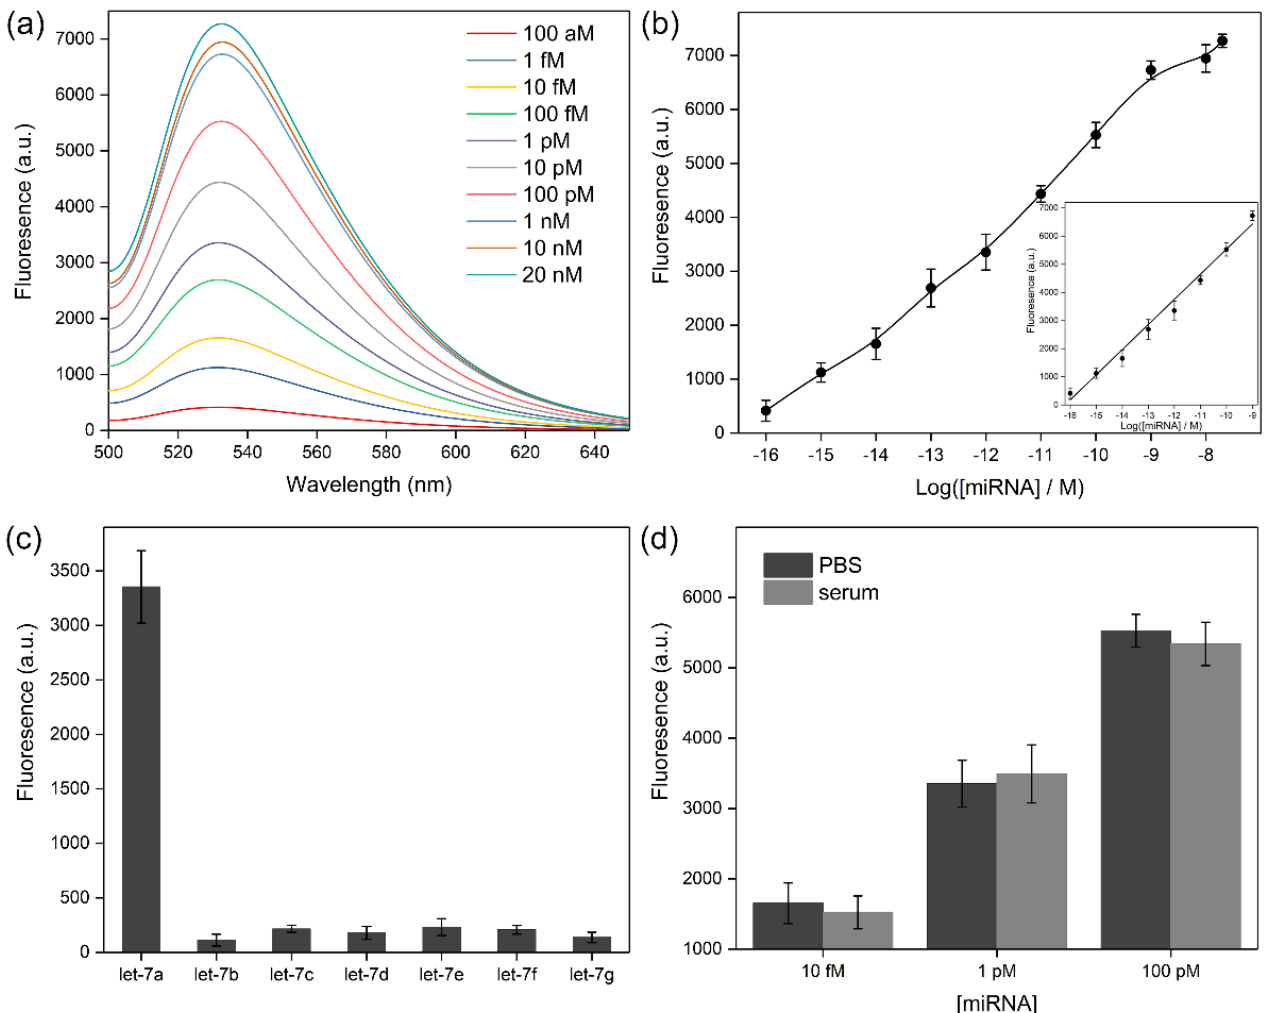
Figure 5. ( a ) Fluorescence emission spectra for the detection of miRNA with different concentrations. ( b ) Calibration curve representing the relationship between peak intensity and miRNA concentration. Inset is the linear range. Error bars represent standard deviations of three independent measurements. ( c ) Selectivity investigation of target and homology miRNAs. ( d ) Fluorescence performances of the sensor in PBS buffer and serum samples spiked with different amounts of miRNA. Table 2. Comparison of the analytical performances of recent miRNA assays.